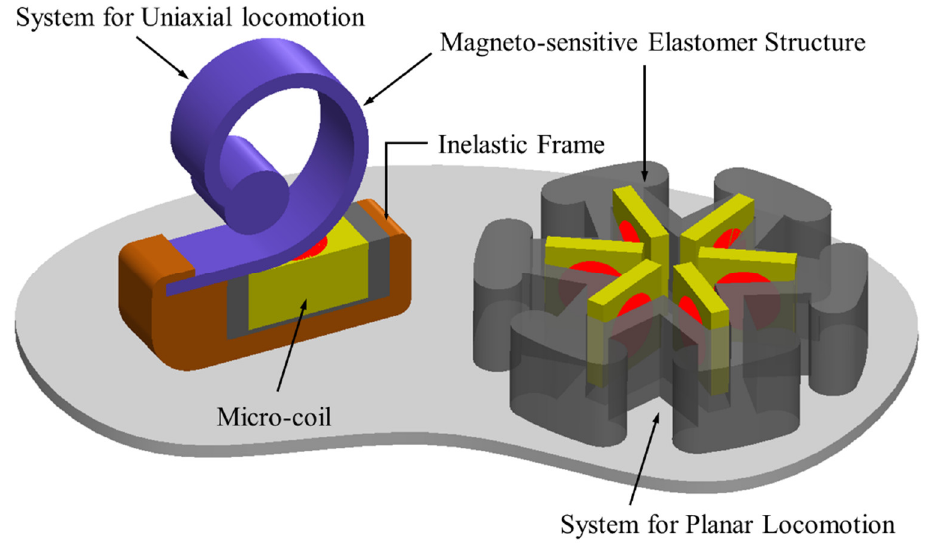
Figure 6. Two different micro-robots featuring MRE body structures [34].